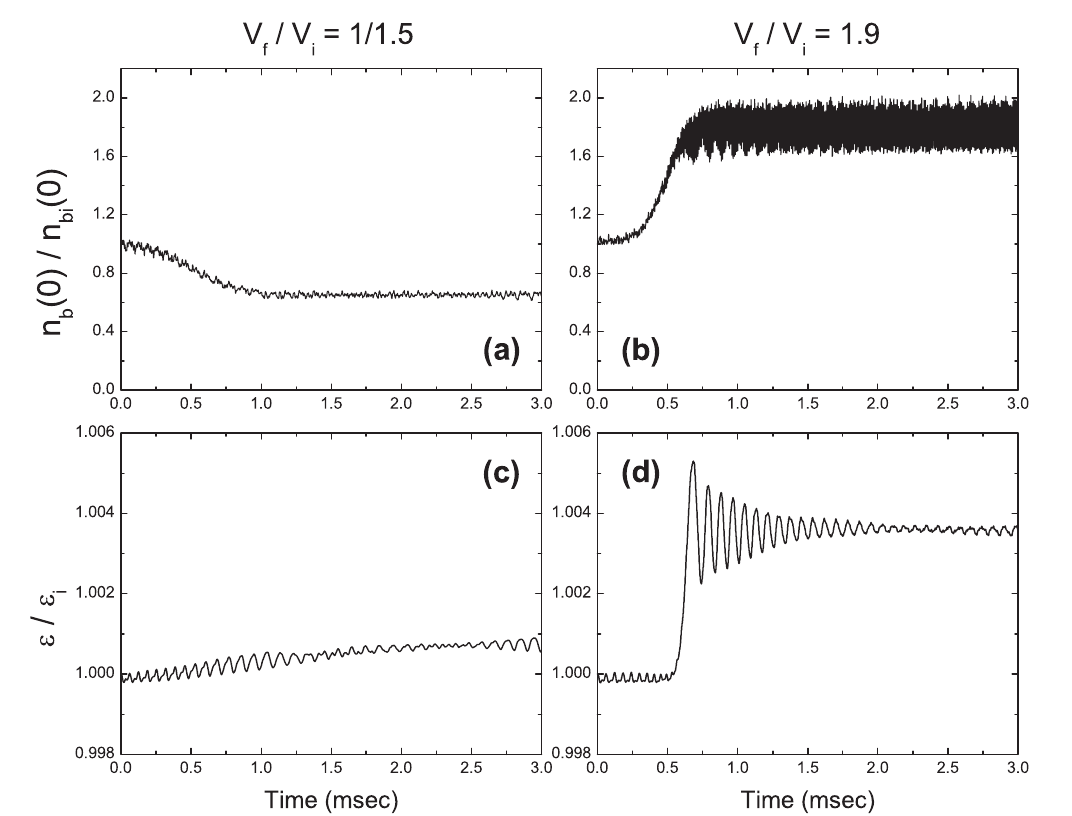
FIG. 12. 2D WARP simulations for an alternating-gradient quadrupole lattice. The evolution of the normalized on-axis density (cid:5) 0 (cid:6) =n (cid:5) 0 (cid:6) and normalized transverse emittance (cid:2)=(cid:2) n b bi 60 kH z . Frames (a) and (c) correspond to the case with V (cid:2) 1 : 9 and N (cid:2) 20 V =V f i t